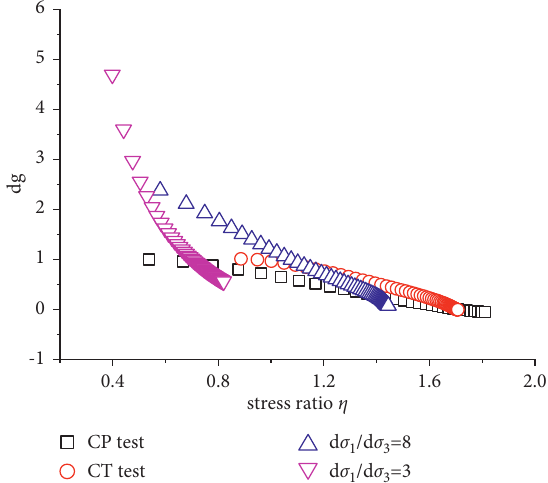
Figure 3: Stress-dilatancy of Yixing rockfill materials along dif- ferent loading